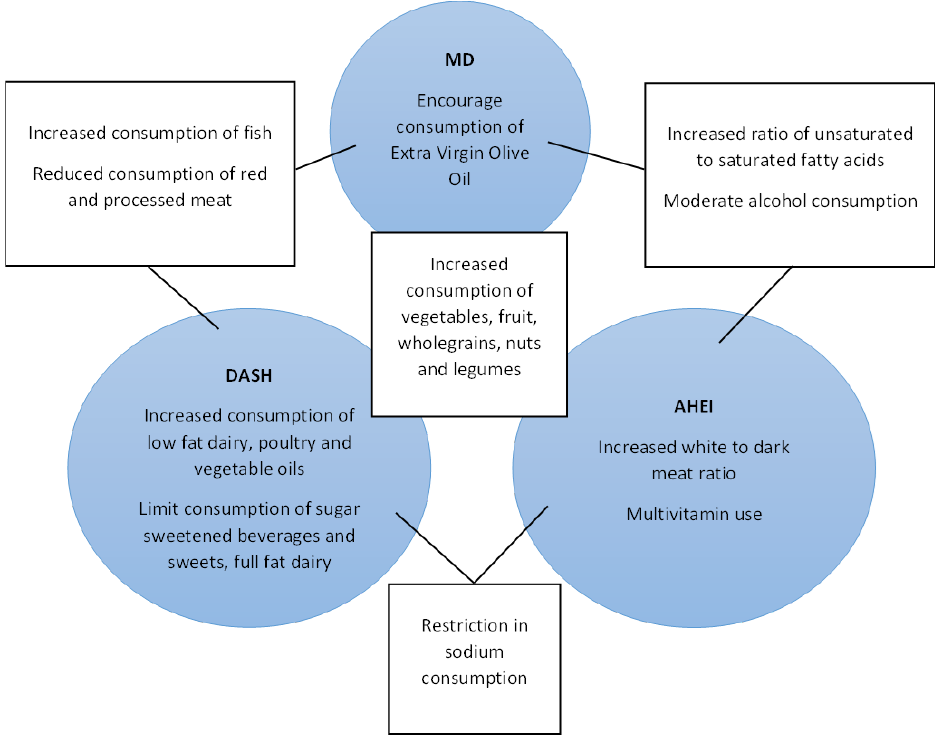
Figure 3. Dietary components of the MD , DASH , and AHEI , arranged to depict the similarities between the dietary patterns.